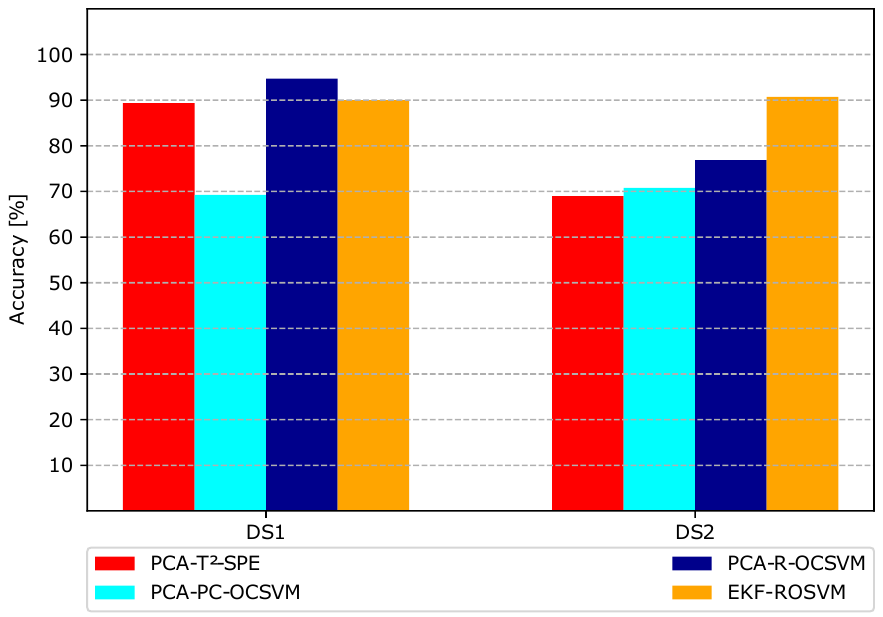
Figure 2. Accuracy of the approaches for